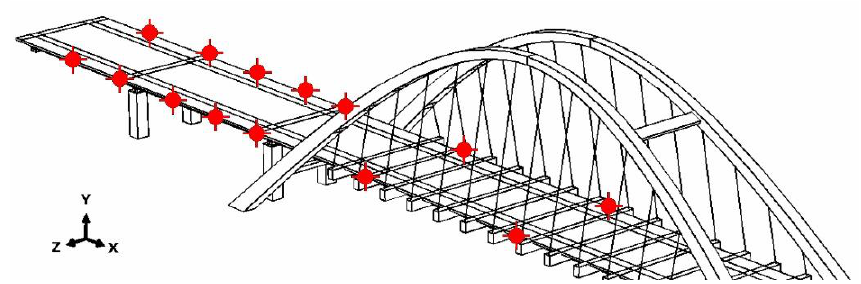
Figure 7. Layout of measurement points for evaluation of modal properties of the bridge.